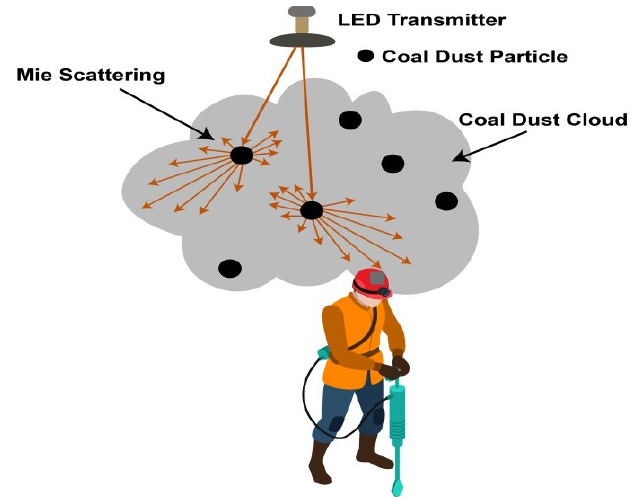
Figure 7. Basic outline of scattering